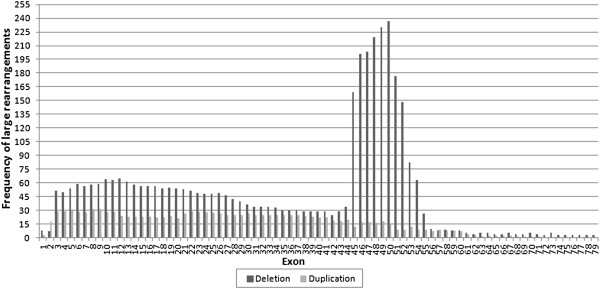
Arrangement frequency of each exon in the DMD gene (625 deletions and 118 duplications).